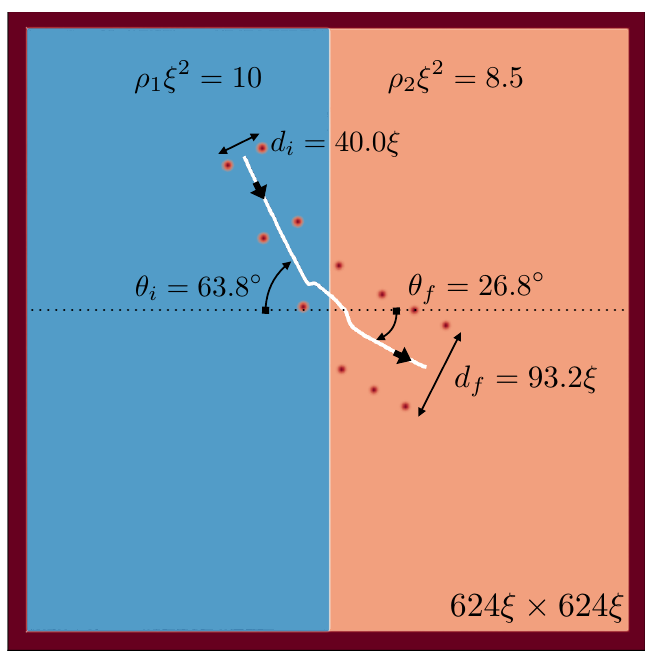
= 40.0 ξ ) dipole is incident upon the large step i = 63.8 ◦ ). The dipole undergoes re- i